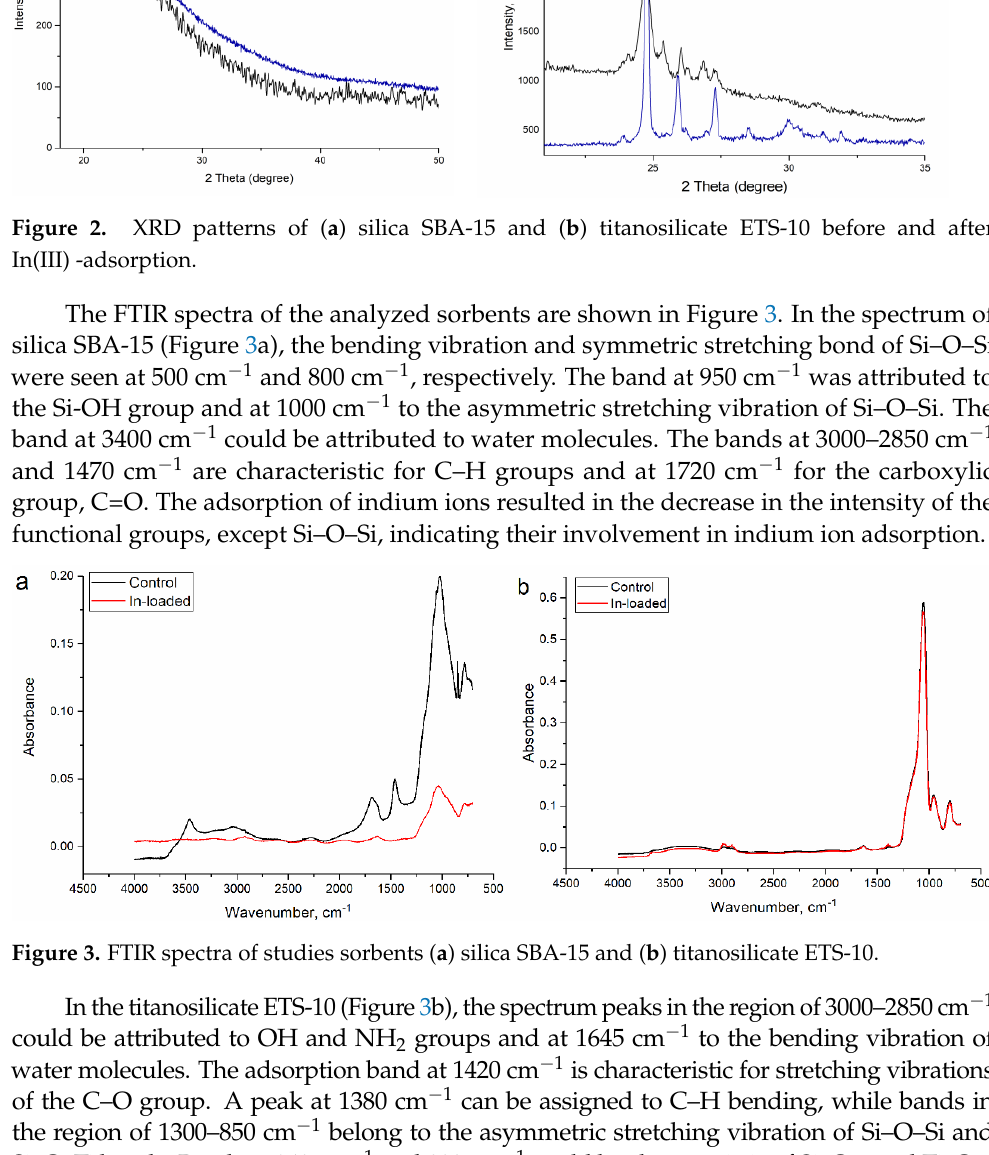
Figure 3. FTIR spectra of studies sorbents ( a ) silica SBA-15 and ( b ) titanosilicate ETS-10.